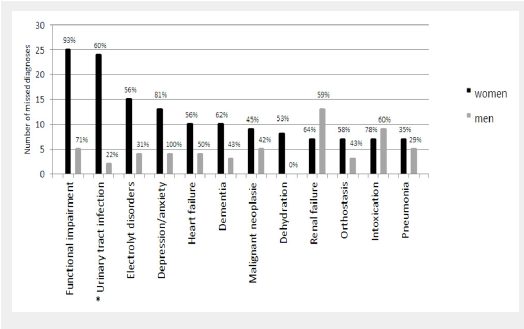
Missed diagnoses by gender. Missed diagnoses are shown on the y-axis in absolute numbers and in percentages (above each bar). Diagnoses are shown on the x-axis. * The difference between men and women was significant (urinary tract infection, p =